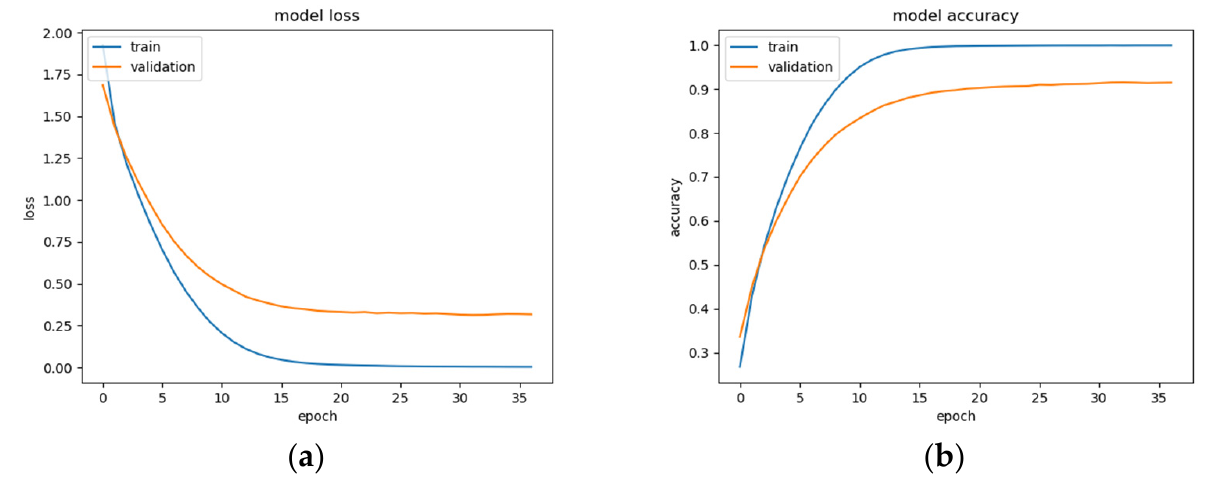
Figure 16. BLSTM model performance : (a ) Categorical cross-entropy loss of the utilized BLSTM model on the raw EEG data; ( b ) categorical accuracy of the utilized BLSTM model on the raw EEG data.